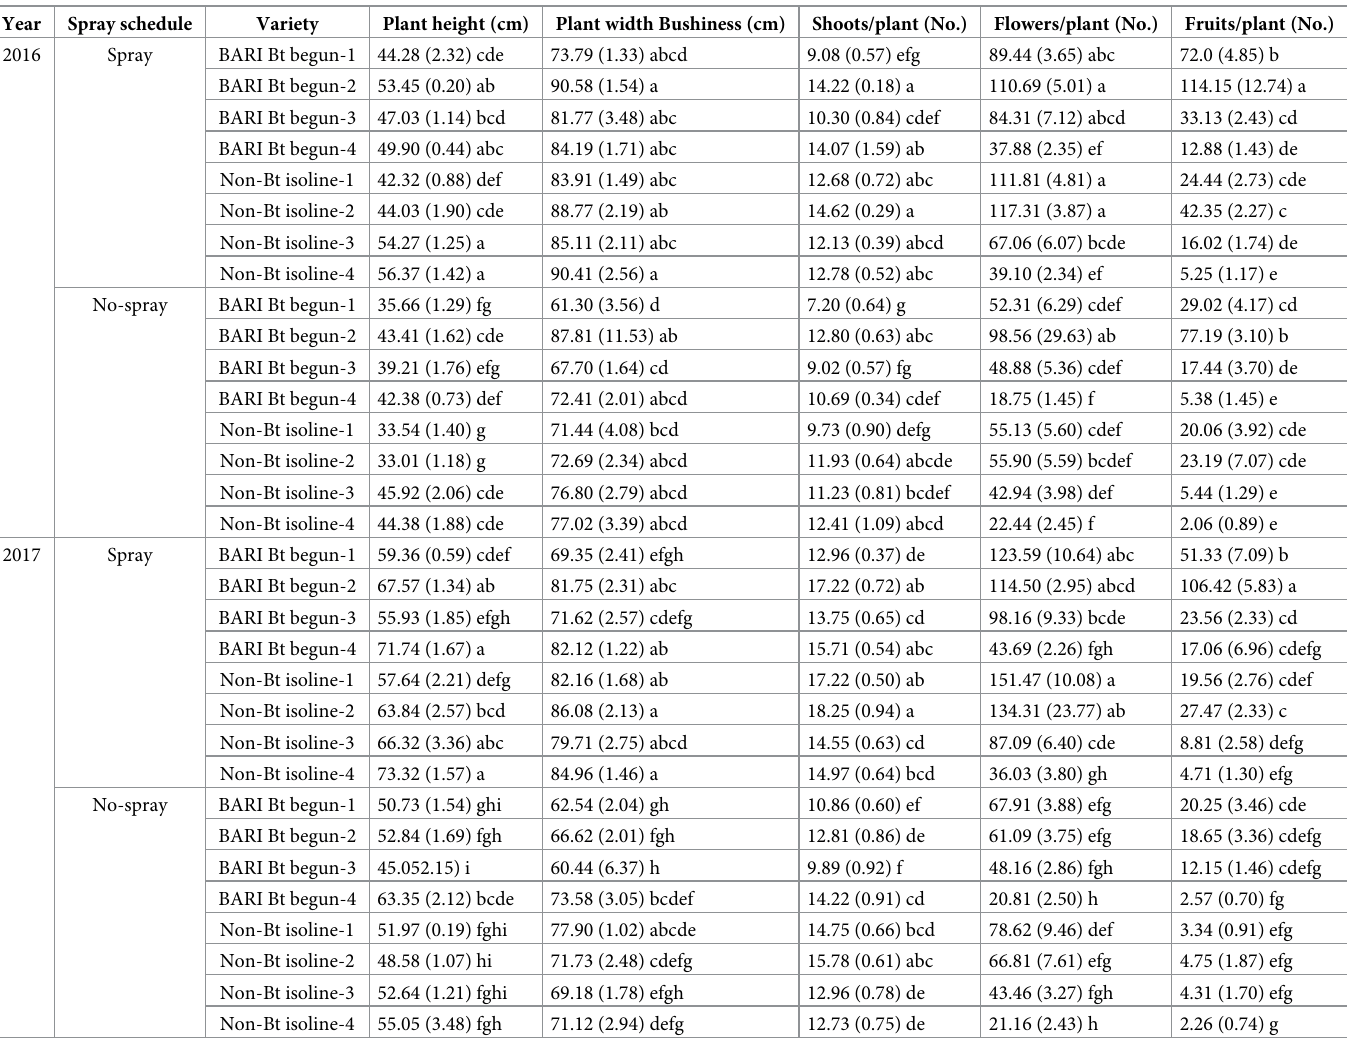
Table 5. Mean values 1 of brinjal agronomic characteristics relative to insecticides and varieties, OFRD, BARI, Bogra, Bangladesh. Year Spray